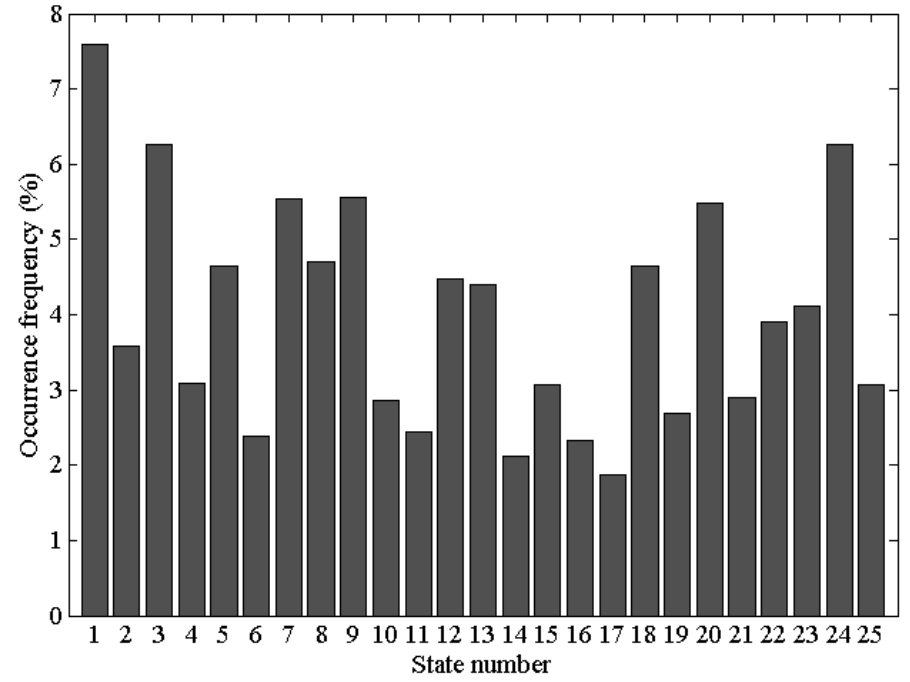
Figure 1. Occurrence frequencies of 25 patterns during 2001–2010 at the SGP site.